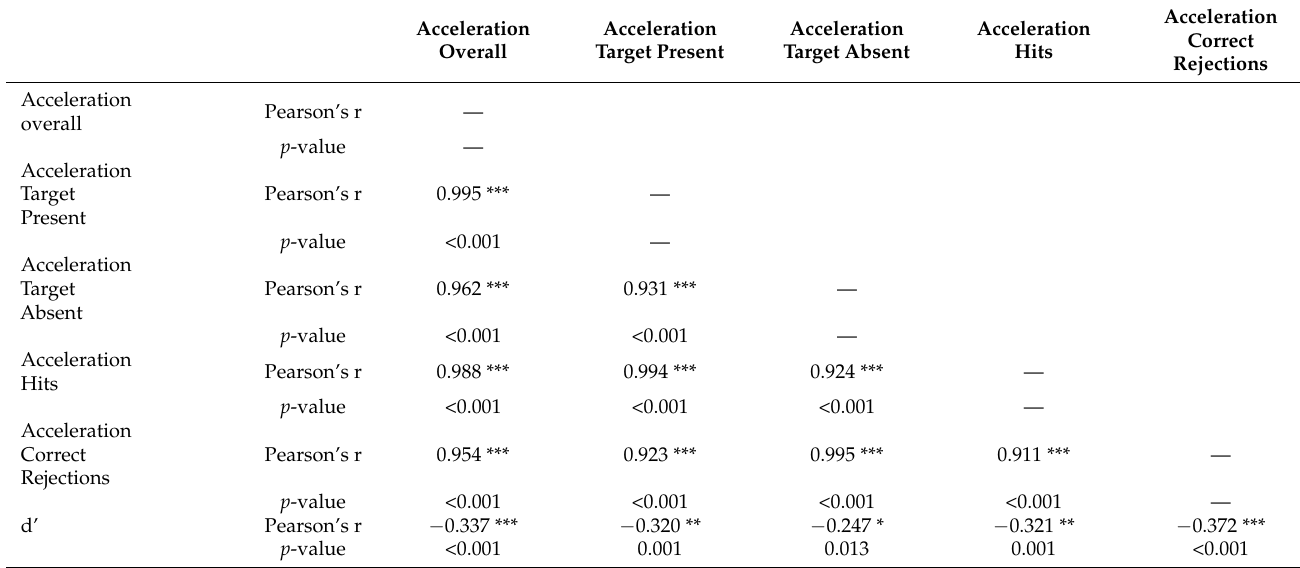
Table 4. Correlations among measures of the VR Goalkeeper